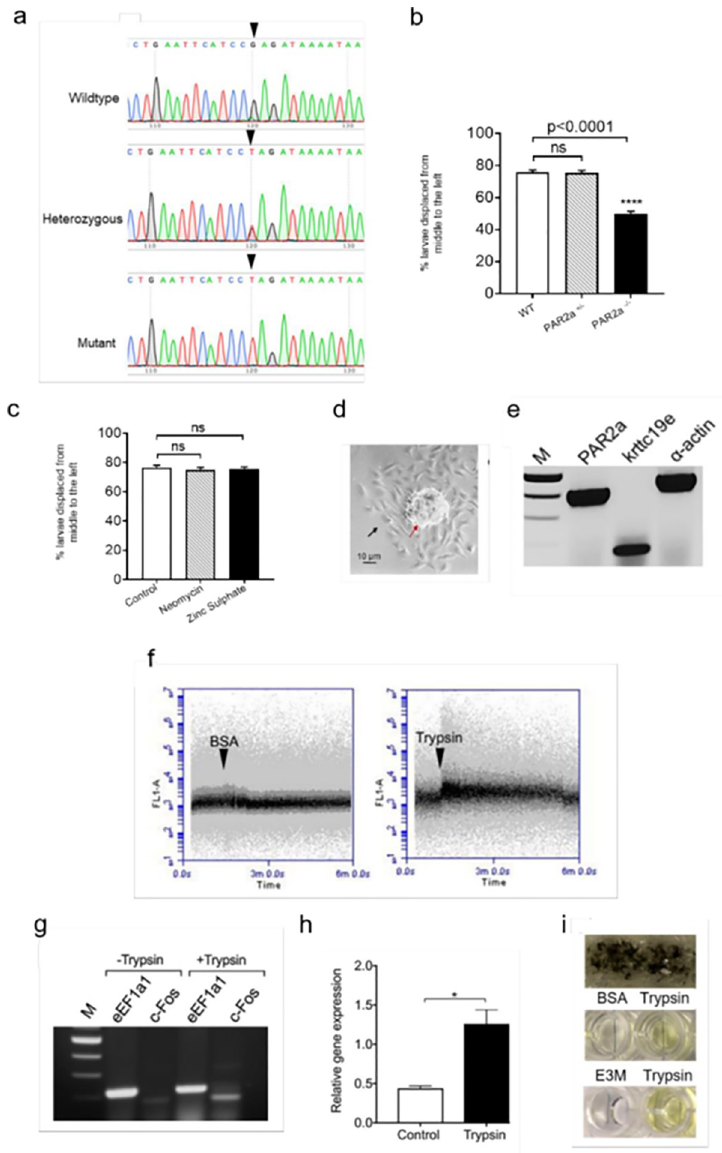
Fig 2. Knockout of par2a and detection of cell type and the components that sense trypsin signaling. a. DNA sequences of par2a gene of the wild-type (top), heterozygous (middle), and homozygous knockout mutants (bottom) are shown as chromatograms. The arrowhead marks the mutation. Only sequences around the par2a gene mutation are shown. b. The relation between trypsin repelling results and par2a knockout mutants. Showing for each genotype (WT, wild-type; par2a+/ter , heterozygote; par2ater/ter , homozygous knockout) the percent of larvae displaced from the middle to the left of the mini-tank opposite to trypsin administration. c. Evidence that the trypsin-sensitive surface cells are not neuromast or olfactory cells. Comparison of intact larvae and larvae with neuromast cells ablated by neomycin treatment and olfactory cells inactivated by zinc sulphate. Similar percentages of larvae from three groups were displaced from the middle to the left, away from the source of trypsin, suggesting that neuromast cells and olfactory cells were not responsible for the repellent effect of trypsin. (n = 6 experiments; ns, non-significant). d . Phase- contrast image of skin cell culture. Red and black arrows show the scale and skin cells, respectively. e. Confirmation of keratinocytes. RT-PCR products of three genes par2a , krittc19e , and α -actin . M, DNA size markers. Positive amplification of krittc19e and par2a showed that they are keratinocytes having Par2a receptors. f. Calcium signaling in keratinocytes induced by trypsin. The left and right panels are the fluorescence shown by flow cytometry when induced by BSA and trypsin, respectively. g. Induction of c-fos transcripts by trypsin exposure of adult zebrafish. Photograph showing the RT-PCR products of the zebrafish brain RNAs that were not exposed to trypsin (-Trypsin) and were exposed to trypsin (+Trypsin). Lanes show M, DNA size markers, ef1- α labeled as eEF1a1 (internal